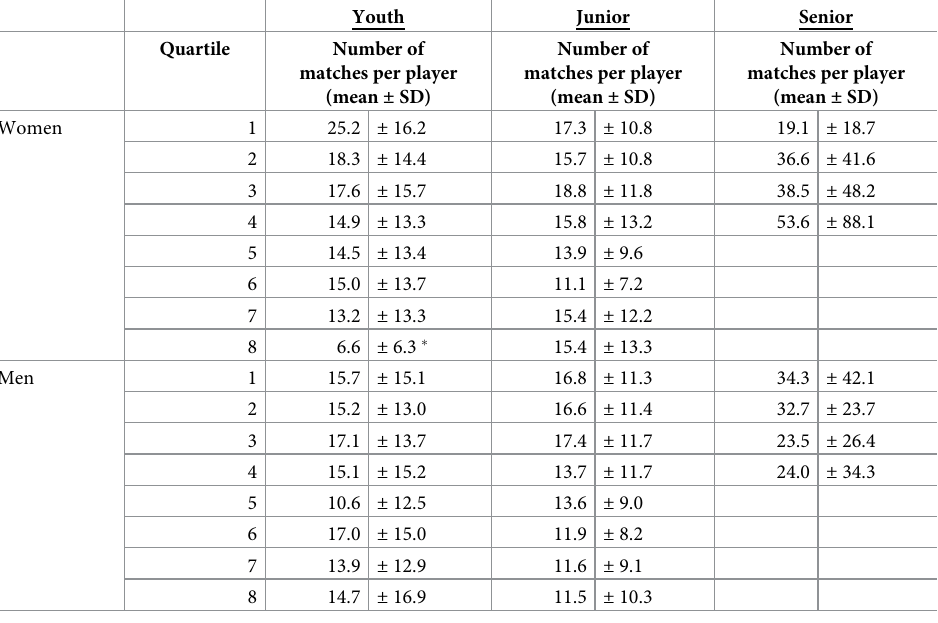
Table 3. Number of matches played per player in the different birth